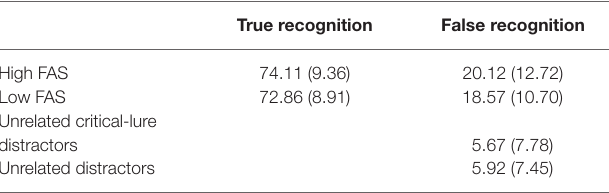
Standard deviations are reported in